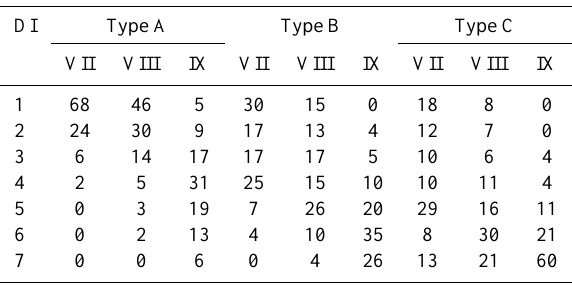
Table 4. Damage probability matrix DPM-2007 (in %) for three types of buildings in Colima (intensity MM from VII to IX).